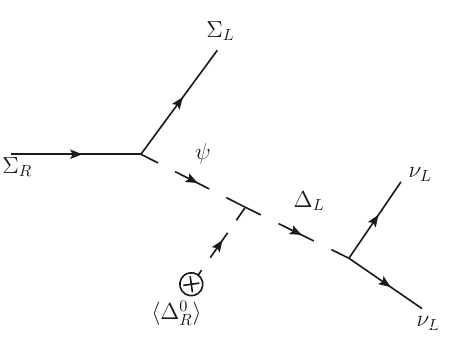
Figure 7 . Feynman diagrams for next to lightest dark matter particle decaying into lightest dark matter particle and two light